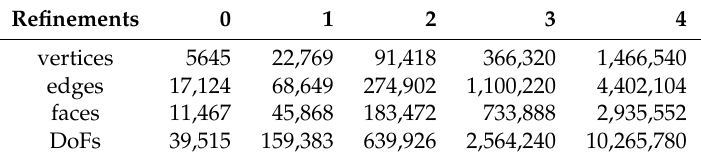
Table 1. Geometry info of the 3D surface ER representation that is used for the evaluation of the population dynamics inspired sPDE model. DoF number at base level and from one to four global refinement levels in space. (The triangular elements are named “faces”.)